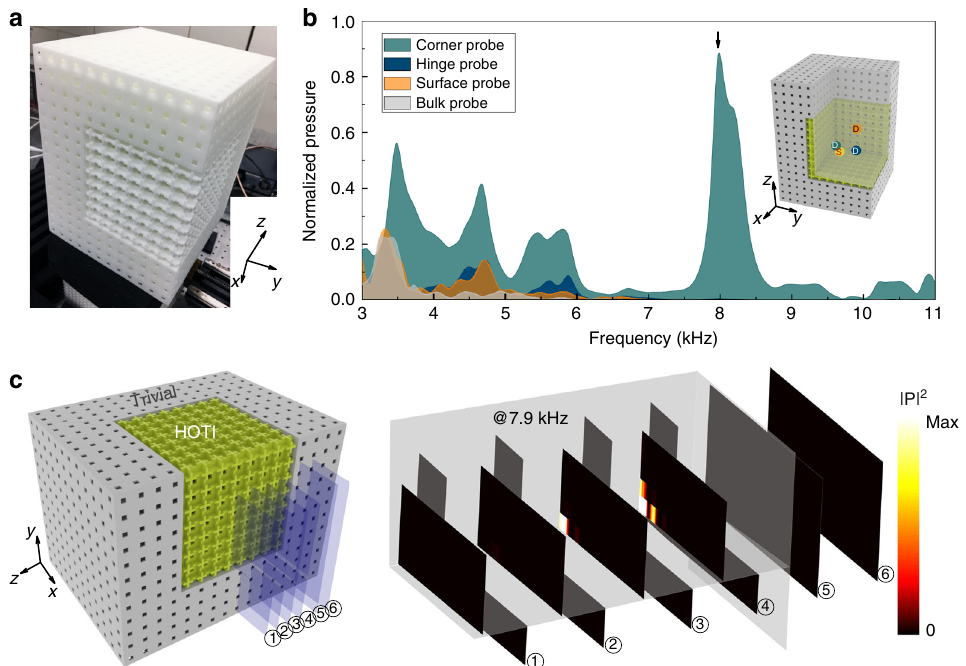
Fig. 4 Topological corner states: boundary with codimension three. a Photograph of the fabricated corner sample, consisting of the topological SC (size: 8 ´ 8 ´ 8 unit cells) enclosed by the trivial SC (thickness 4 a ) in all three directions. To ensure pump – probe experimental measurements, the corner sample is cut to allow open interfaces, as shown in the fi gure. b Measured transmission spectra for four types of pump – probe con fi gurations: the bulk probe (gray), the surface probe (orange), the hinge probe (dark blue), and the corner probe (dark green). The inset depicts the locations of the source and the surface, hinge, and corner probes (the same colors as in the transmission spectra). The location of the bulk probe (not shown in the inset) is in the middle of the topological SC. c Acoustic pressure pro fi le for the corner states excited at the frequency of 7.9 kHz (indicated by the black arrow in b ) and presented using slice plots (the locations of the slices are indicated in the left